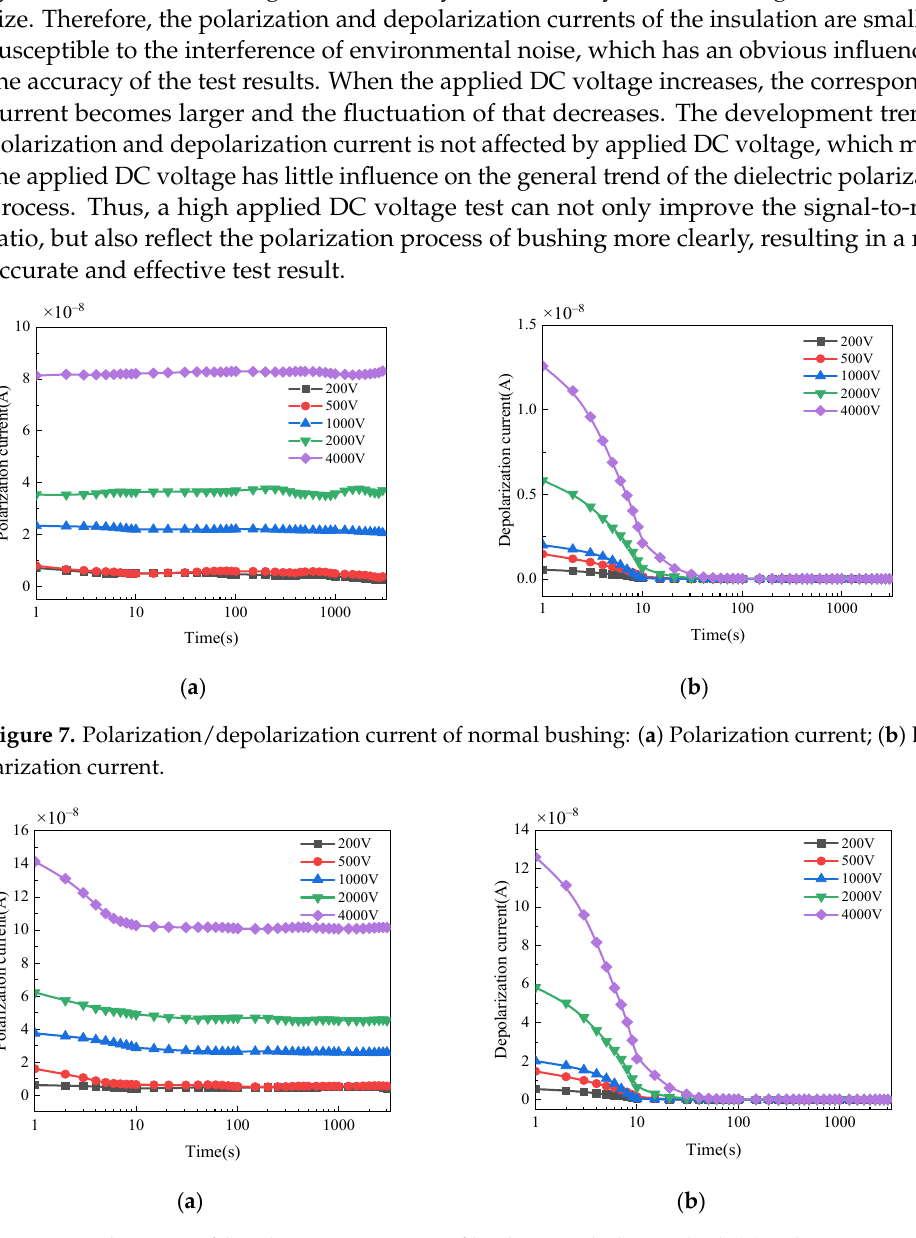
Figure 8. Polarization/depolarization current of bushing with damped oil: ( a ) Polarization current; ( b ) Depolarization